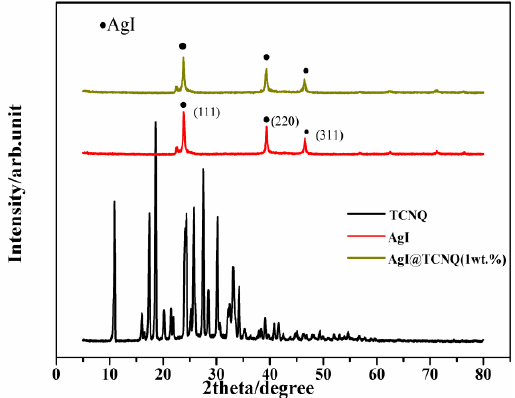
Figure 1. X-ray ray diffraction (XRD) patterns of TCNQ, AgI, and (AgI@TCNQ) photocatalysts.